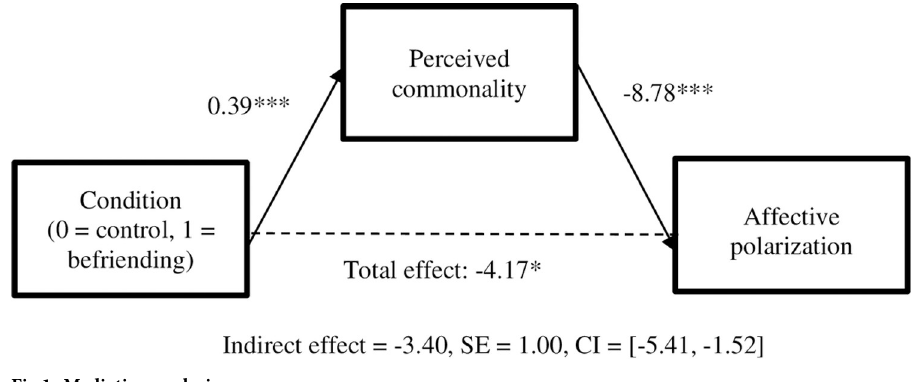
Fig 1. Mediation